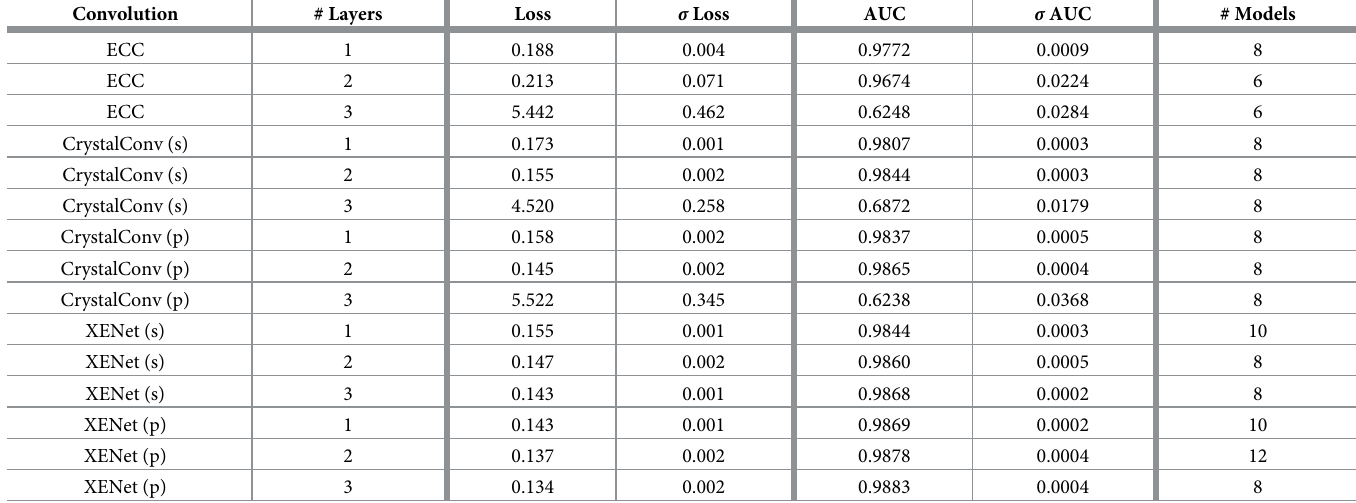
Table 2. Training results. Mean binary crossentropy loss and mean AUC for trained models. σ denotes standard deviation. Lower loss values are considered better whereas higher AUC values are better.